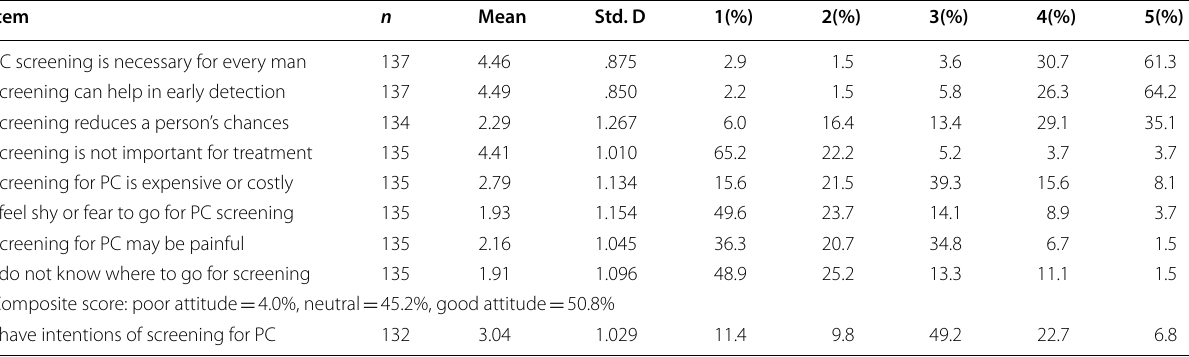
Table 3 Attitude toward early detection